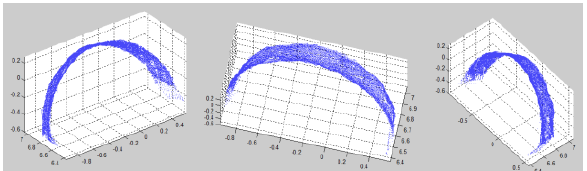
Figure 9: 3D representation of the coordinates list of the annotation